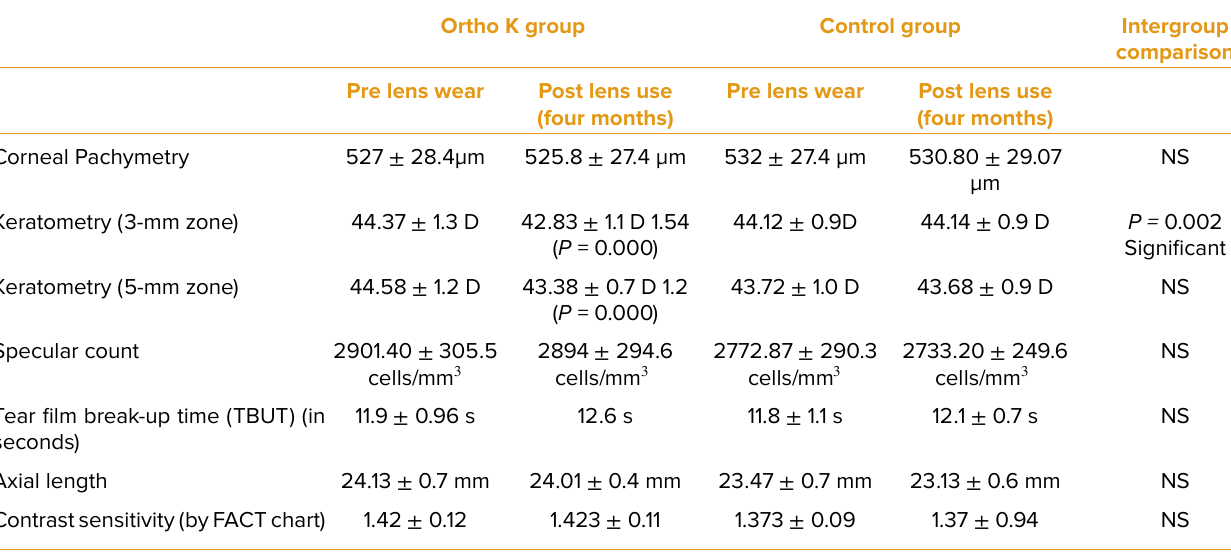
Table 1. Change in corneal pachymetry, 3-mm and 5-mm zone keratometry, specular count tear film break-up time, axial length and contrast sensitivity in the study (Ortho K) and control groups post lens